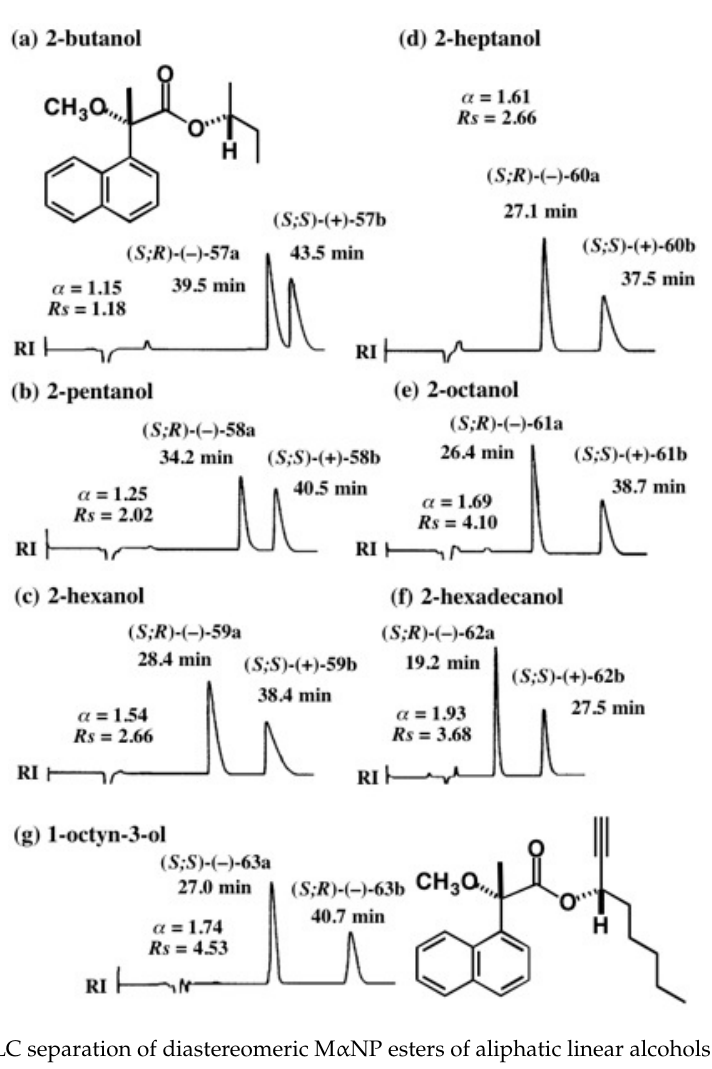
Figure 40. HPLC separation of diastereomeric M α NP esters of aliphatic linear alcohols and acetylene alcohol ( a )–( g ). Reprinted with permission from [58].